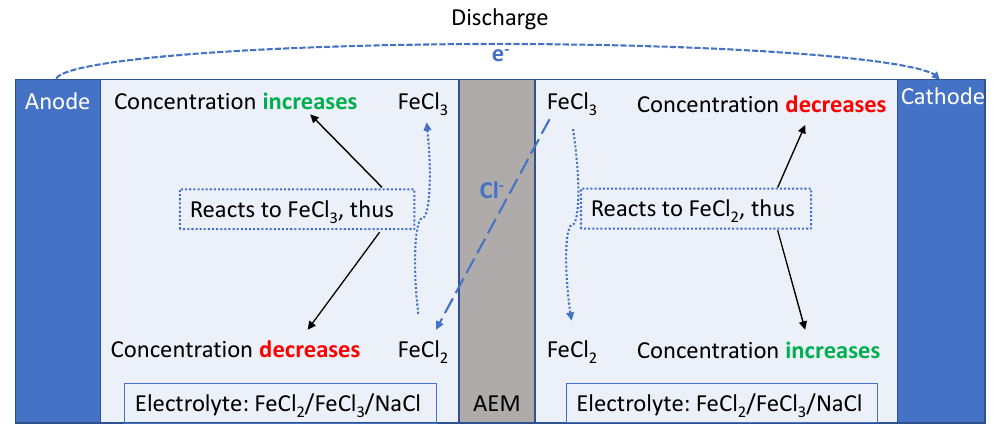
Figure 1. Cell mechanism at discharge until concentration ratio of FeCl 2 /FeCl 3 is 1 on both